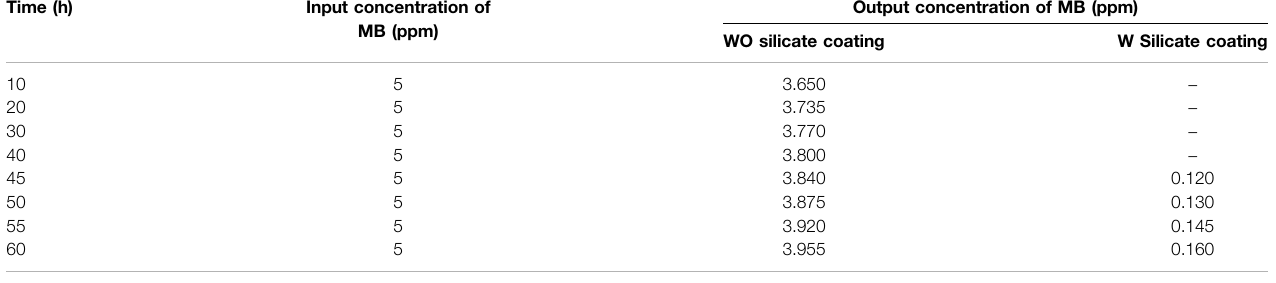
TABLE 5 | Results of the photocatalytic performance of the WO and W silicate coatings. Time